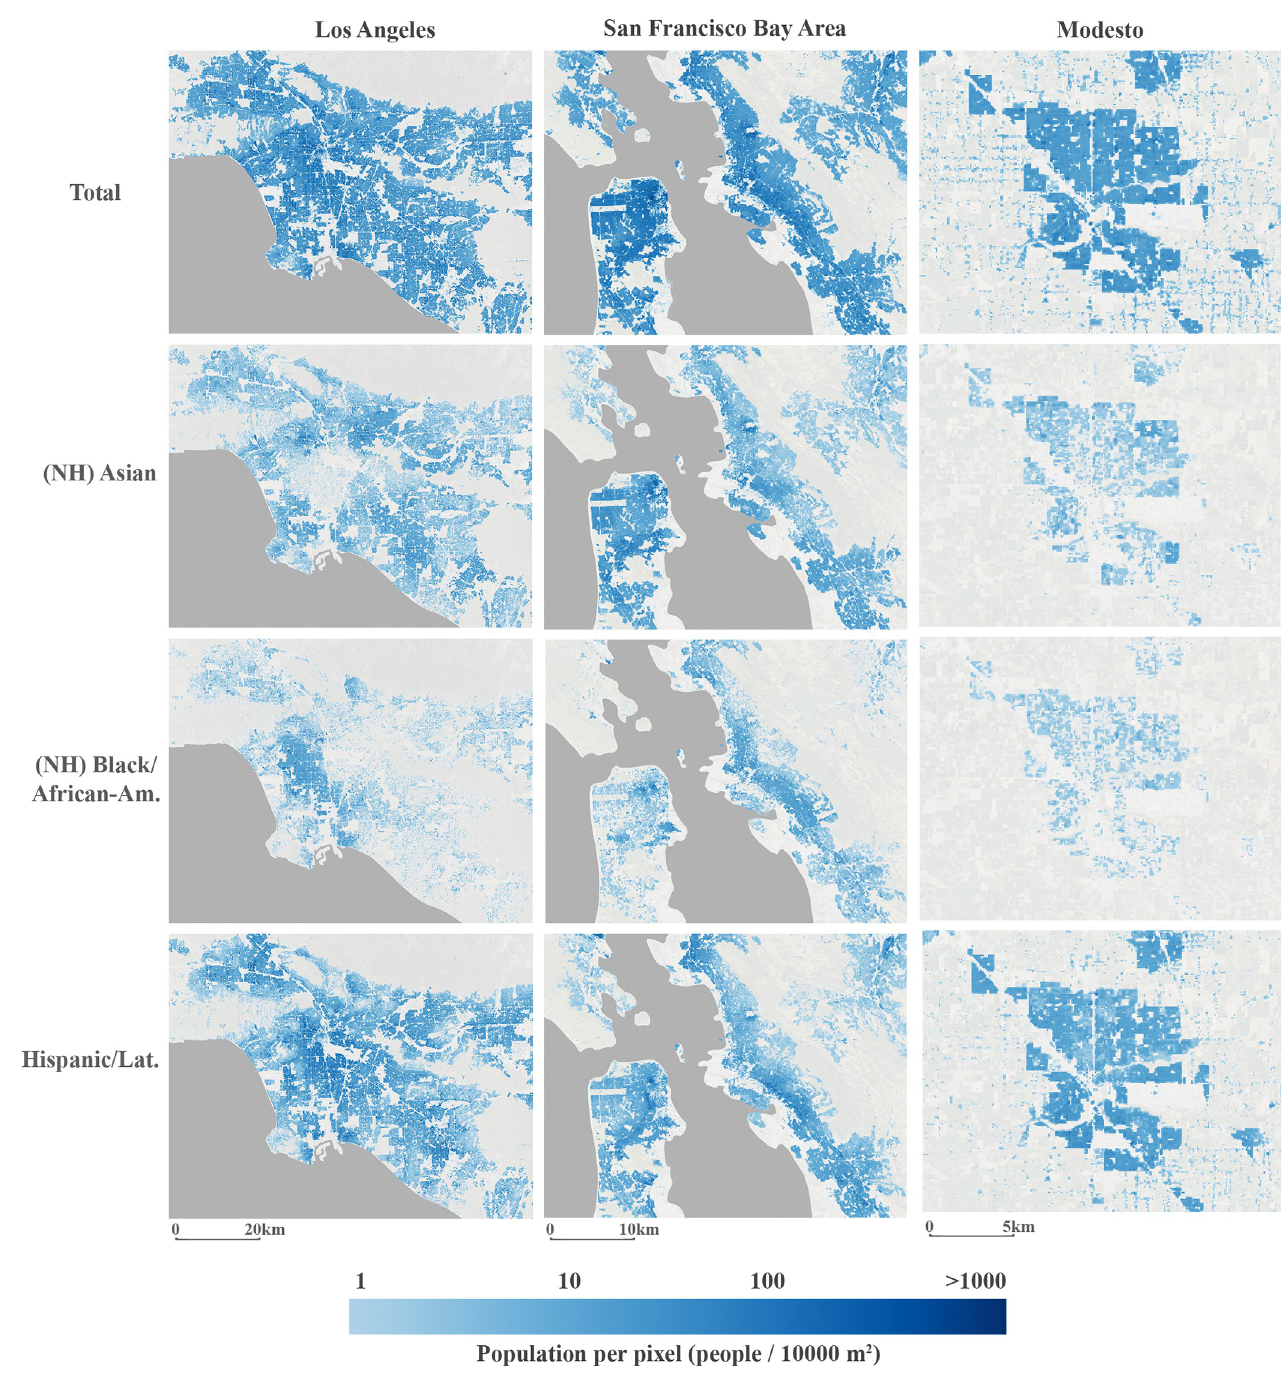
Fig 5. Final CA-POP grids. Examples are shown for four demographic population variables at three different locations in California. (Satellite base imagery source: USGS (NAIP) from The National Map, Ocean boundary layer source: Natural Earth). block scale differs between the two methods. Fig 6 displays SocScape pixel values subtracted from CA-POP as a grid, and demonstrates that SocScape distributes low population counts across the majority of open space within blocks, whereas CA-POP more accurately sets these